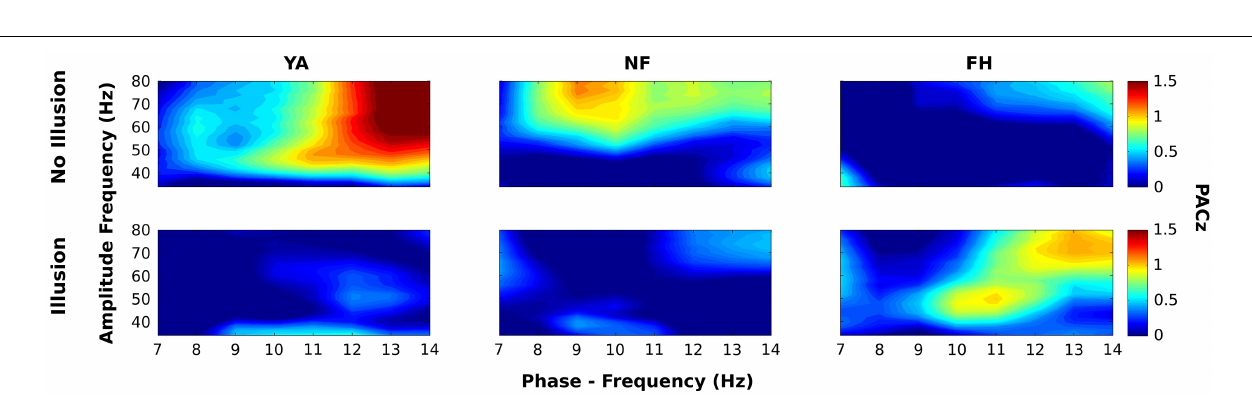
FIGURE 6 | Group average maps of phase-amplitude coupling (PAC) within electrode Oz. Average PAC z scores across groups (YA: left column; NF: middle column; FH: right column) are displayed for each phase-amplitude pair during non-illusion (top row) and illusion (bottom row) conditions. For all maps, the phase frequency (7–14 Hz) is displayed along the x -axis while the amplitude frequency (30–80 Hz) is displayed along the y -axis.